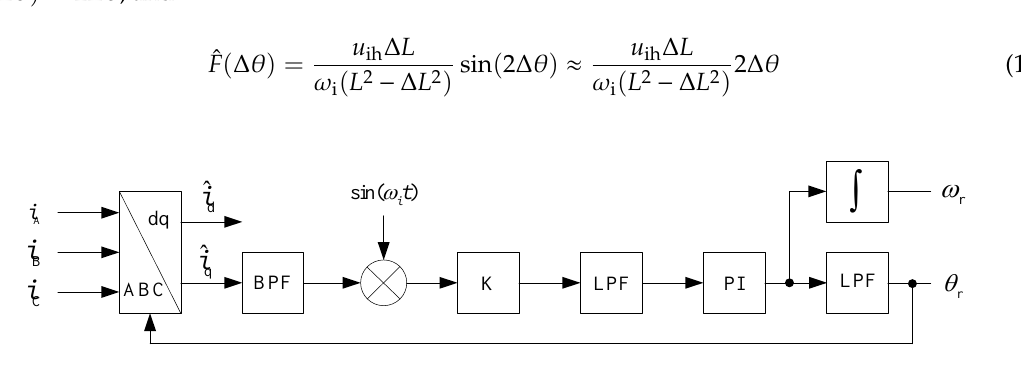
Figure 4. Estimation process of rotor position.